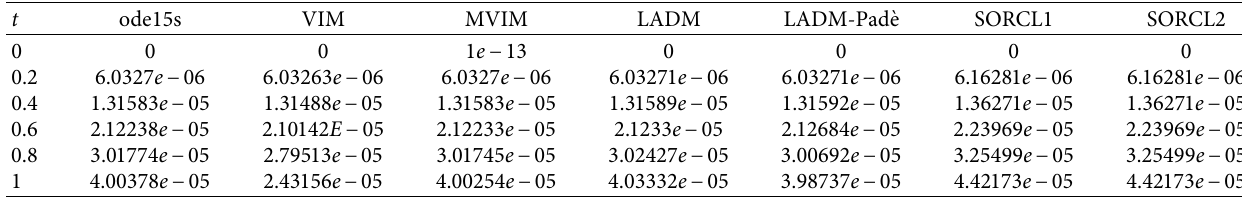
Table 2: Numerical comparison for values of I ( t ) , with ω � 0 . 57 and θ � 1 using diferent methods.